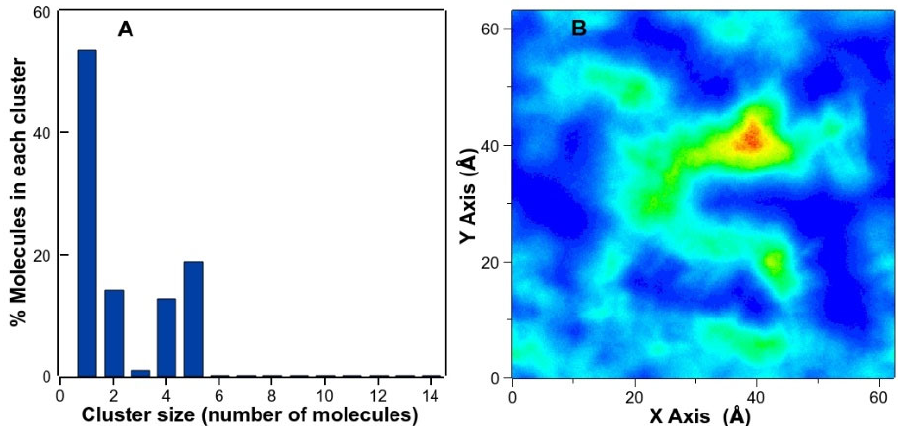
Figure 8. ( A ) Cluster size distribution of TMBC molecules in the DMPS membrane. ( B ) Density map of TMBC molecules of the DMPS/TMBC membrane corresponding to the x y plane of the simulation box. TMBC density increases from blue to red color.